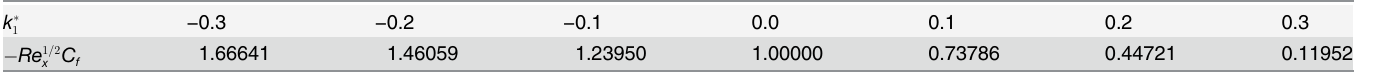
Conclusions Boundary layer flows of two viscoelastic fluids over a linear stretching surface satisfying Catta- neo-Christov heat flux is analyzed. The main observations of this study are summarized below: (cid:129) Velocity profile f 0 ( η ) and momentum boundary layer thickness are reduced when we enhance the positive values of k (cid:3) 1 while opposite behavior is observed for the negative values of k (cid:3) 1 . Table 3. Values of skin friction coefficient (cid:2) Re 1 = 2 x C f for different values of viscoelastic parameter k (cid:3) 1 .